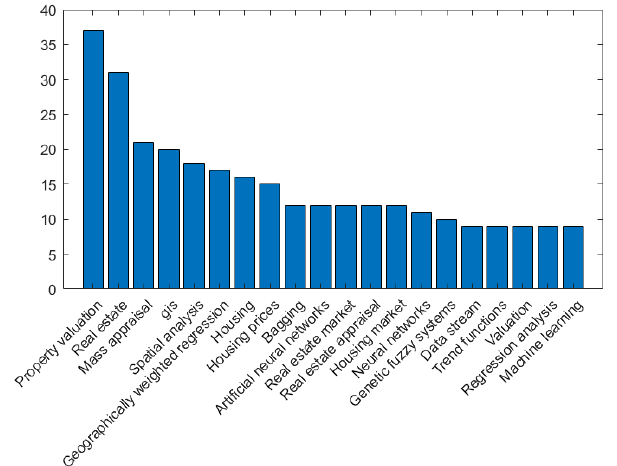
Figure 3. Frequencies of top twenty keywords in Scopus database.